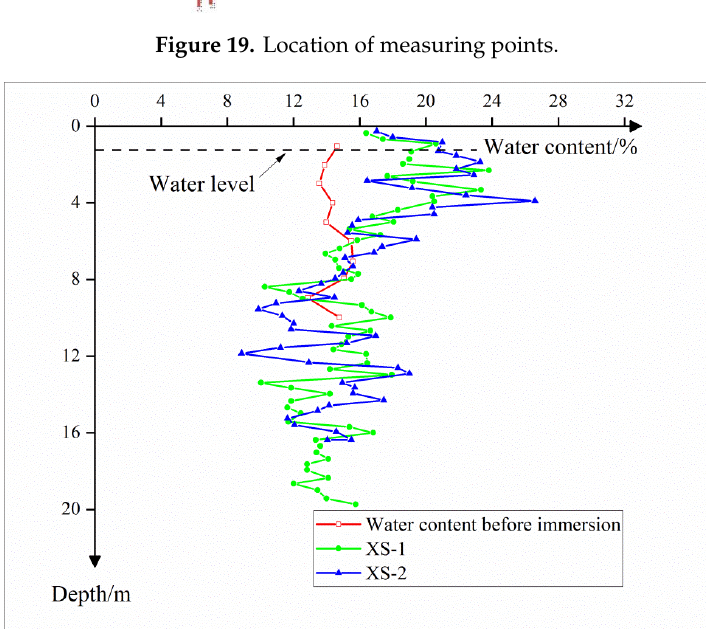
Figure 20. Test results of water infiltration depth.